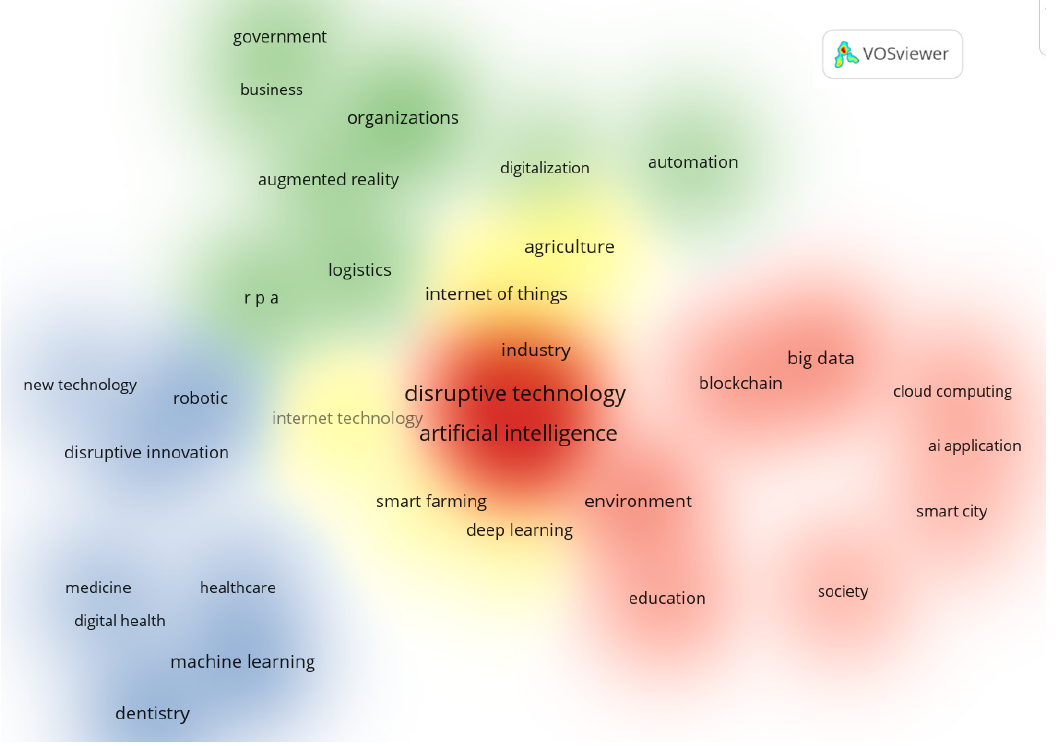
Figure 6. VOSViewer density visualization based on cluster density for technologies and impacted sectors.